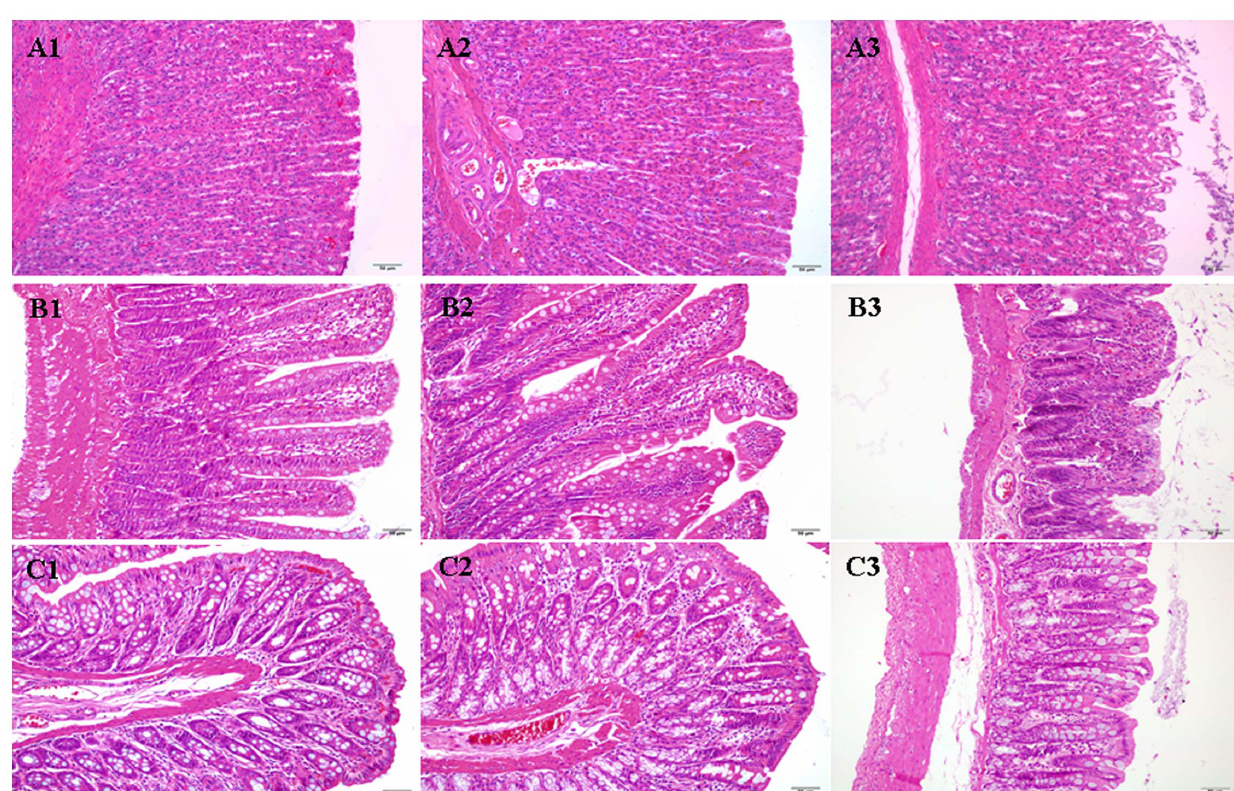
Figure 6. HE photomicrographs of rat gastric and intestinal tissue sections after oral administration of COS at the dosage of 25 mg/ kg. All panels represent cross-sections of gastric and intestinal tissues. Jejunum represents small intestine. The original magnification was 20 6 object lens for stomach and jejunum, 40 6 object lens for colon. A, B and C represent stomach, jejunum and colon, respectively. A1–C1 (PBS); A2–C2 (COS) and A3–C3 (Triton